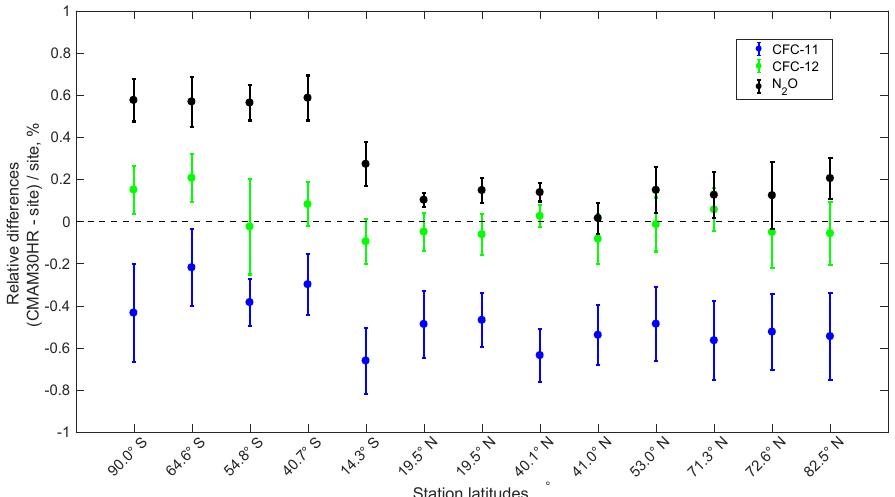
Figure 1. Comparison of CMAM30HR simulations of CFC-11 (blue), CFC-12 (green), and N 2 O (black) to the HATS surface flask network of measurements at various locations around the world. Locations of measurement sites are indicated by latitude. Relative differences are calculated as the difference between the concentration at the surface site and the lowest model layer of the nearest neighbour grid box to the site in the CMAM30HR output, divided by the measured concentrations. The relative differences were calculated based on the monthly averaged observations and simulations. Shown here are the mean of the relative differences between May 2004 and June 2010 and the error bars indicate 1 standard deviation of the mean of the relative differences over the time